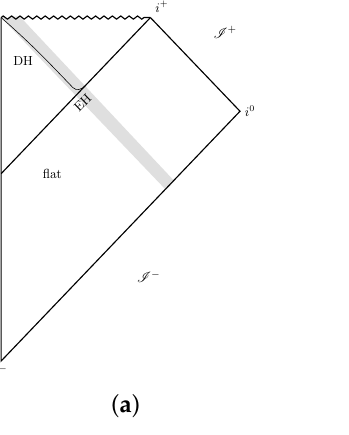
. Note I − would lead to a I −